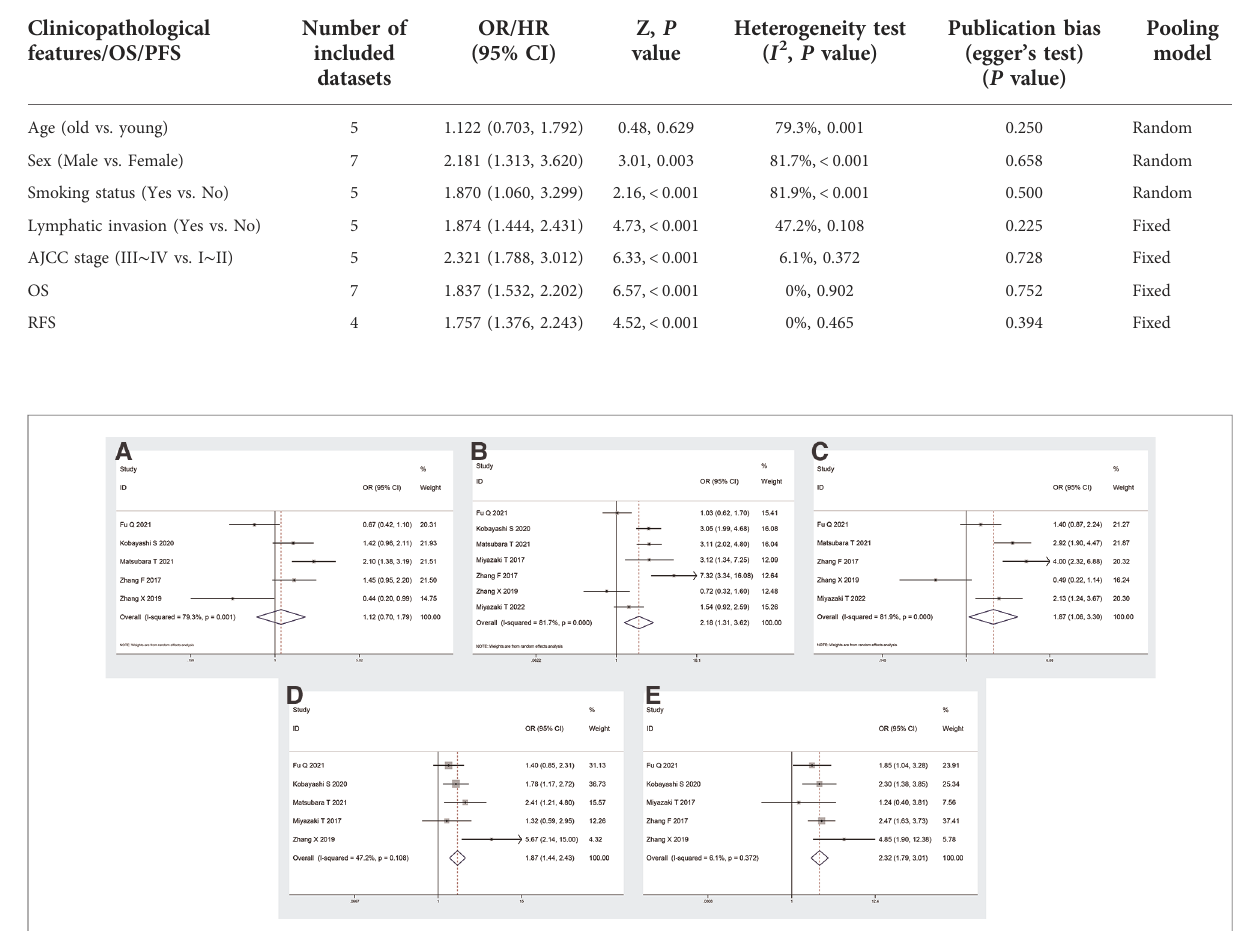
TABLE 3 Main results of meta-analysis and publication bias between CAR and clinicopathological characteristics, overall survival (OS) and progression-free survival (PFS).